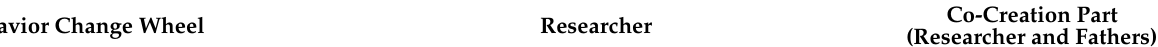
Table 1. Different steps of the intervention development process, which is based on the behavior change wheel and co-creation.